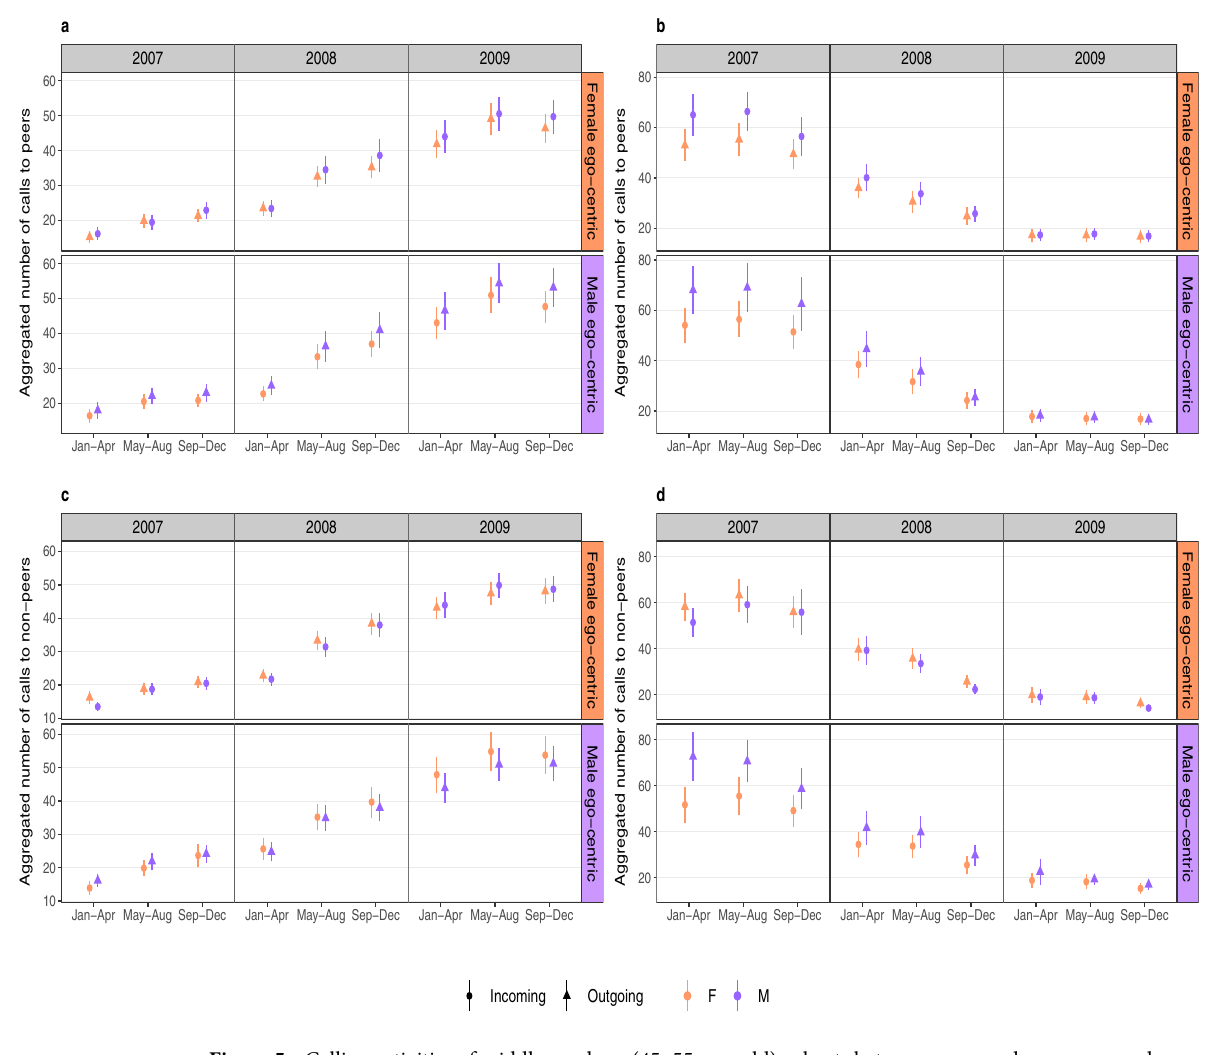
Figure 5. Calling activities of middle-aged age (45–55 year old) cohorts between peers and non-peers and having interactions with their opposite genders. The aggregated calling activities of middle-aged cohorts between their peers (having age differences of less than 10 years) has been shown in ( a ) and ( b ) along with non- peers (having age differences of 20 to 40 years) in ( c ) and ( d ). The plots on the left exhibit those relationships that form a close bond and the plots on the right exhibit decay of close bonds. The orange/violet coloured panels on right of each of the plots represent female/male egocentric network. The filled triangles/circles represent outgoing/incoming calls and orange/violet colour of the points represent calls initiated by females/males in their respective networks. We find that middle-aged individuals calling their peers have slightly higher male-initiated calls than females in both forming and decaying relationships. Their calling activity with non-peers show a consistent behaviour with the adult cohorts’ interaction with non-peers in Fig. 4c where they are receiving slightly higher number of calls from the younger opposite gender individuals. However, we find that when relationship decays the males are making higher number of calls to the younger